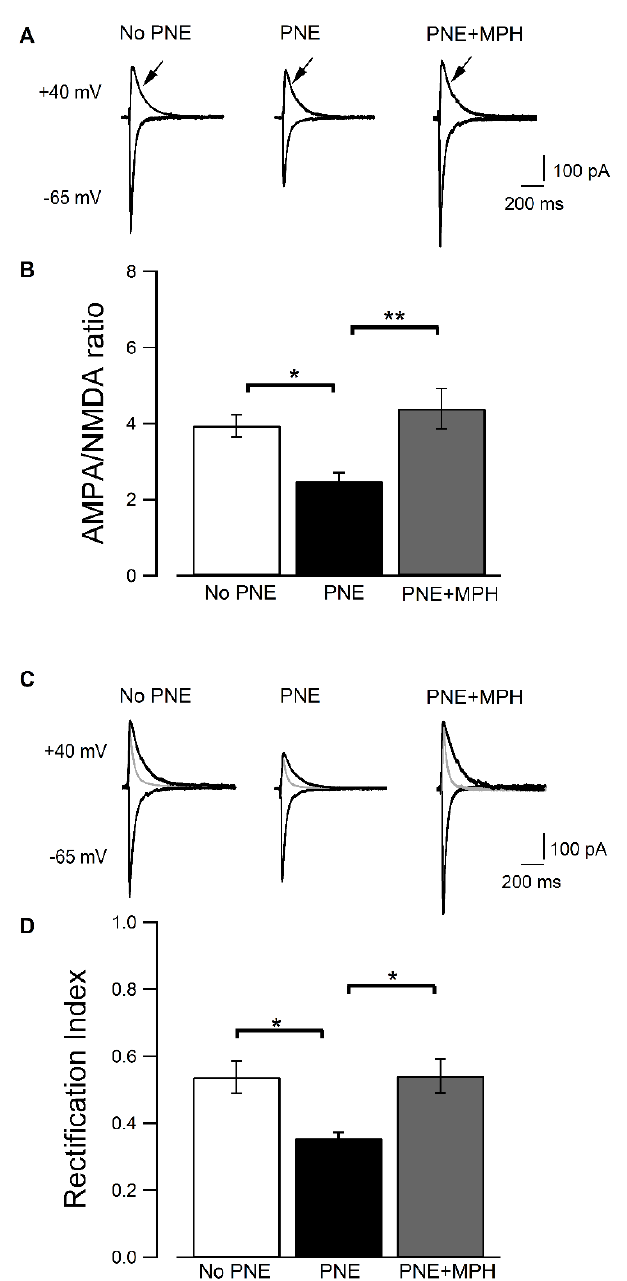
Figure 3. AMPAR EPSCs are reduced in hippocampal neurons of PNE mice with a decrease in the rectification index and restored to normal by MPH. Whole − cell voltage clamp recordings. ( A ) EPSCs measured at +40 and − 65 mV in pyramidal neurons contained in brain slices from no − PNE, PNE, and MPH-treated PNE mice, arrow indicated NMDA component. ( B ) Ratios of EPSC amplitudes generated by AMPARs vs. those of NMDARs. That ratio is significantly reduced in PNE neurons (no − PNE: 3.945 ± 0.29, n = 5,13; PNE: 2.483 ± 0.23, n = 7,15, * p < 0.05) compared to no − PNE neurons and restored by MPH (no − PNE: 3.945 ± 0.29, n = 5,13; PNE + MPH: 4.387 ± 0.53, n = 4, ** p < 0.01; one-way ANOVA F (2,24) = 6.53 followed by Turkey post hoc test). ( C ) AMPAR EPSCs (recorded after perfusion with 5µM AP-5 to suppress NMDAR-generated currents) measured at +40 and − 65 mV in pyramidal neurons from no − PNE, PNE, and MPH-treated PNE mice. Gray traces: Outward EPSCs before perfusion with AP-5. ( D ) Rectification indices of AMPAR EPSCs recorded in pyramidal neurons from no − PNE, PNE, and MPH-treated PNE mice. The rectification index is significantly lower in PNE neurons (PNE: 0.354 ± 0.019, n = 5,11; no − PNE: 0.538 ± 0.048, n = 6,9; * p < 0.05) compared to no − PNE neurons, whereas in neurons from MHP-treated PNE mice, it is significantly different from